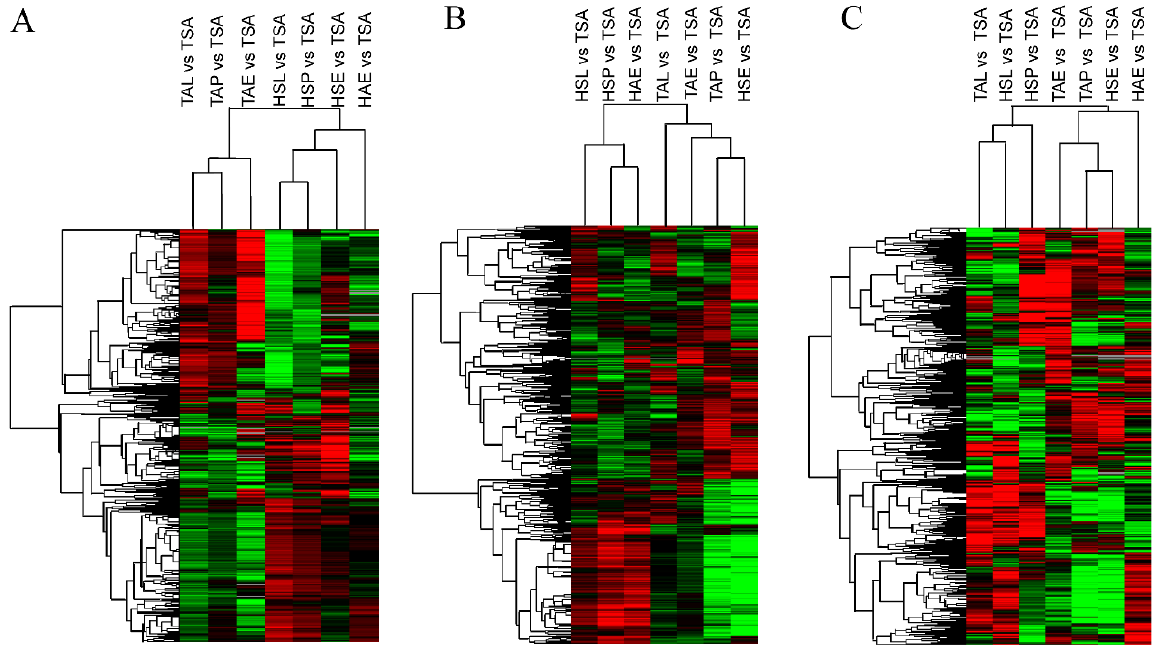
Figure 3. Hierarchical Clustering of DE mRNAs among seven group comparisons. ( A ) The hierarchical clustering result of DE mRNAs in Hypothalamus. ( B ) The hierarchical clustering result of DE mRNAs in pituitary. ( C ) The hierarchical clustering result of DE mRNAs in ovary.